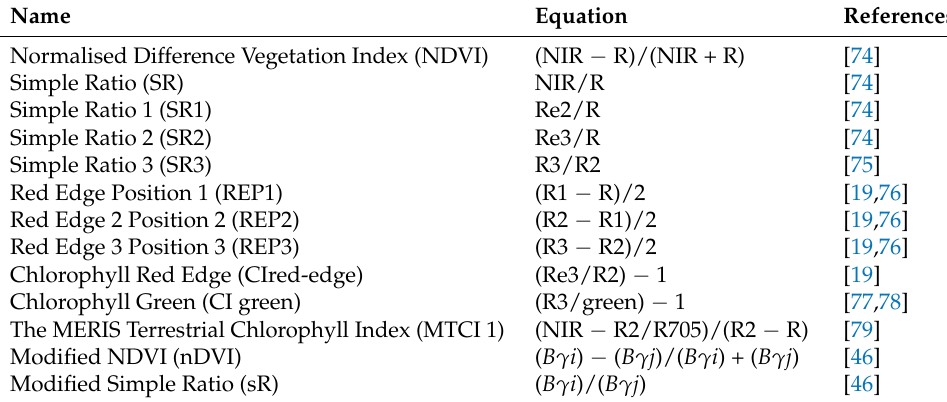
Table 2. Vegetation indices used in this study. The Sentinel-2 band IDs are used in the formulas (as per Section